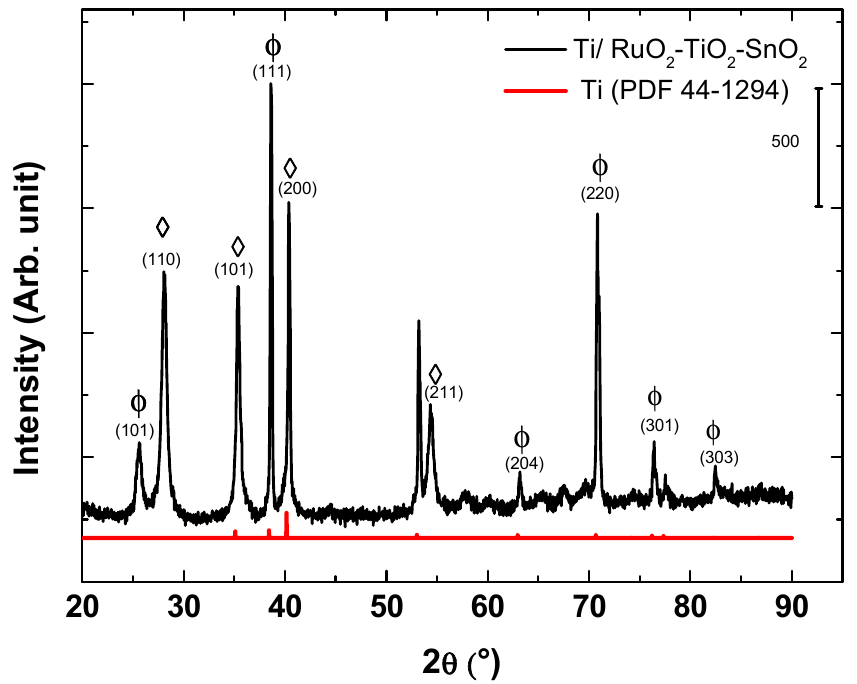
Figure 1. XRD pattern for the DSA ® Ti/RuO 2 -TiO 2 -SnO 2 (50:40:10 atom. %): ( Φ ) RuO 2 tetragonal; ( ◊ ) ( ♦ ) TiO 2 TiO 2 .